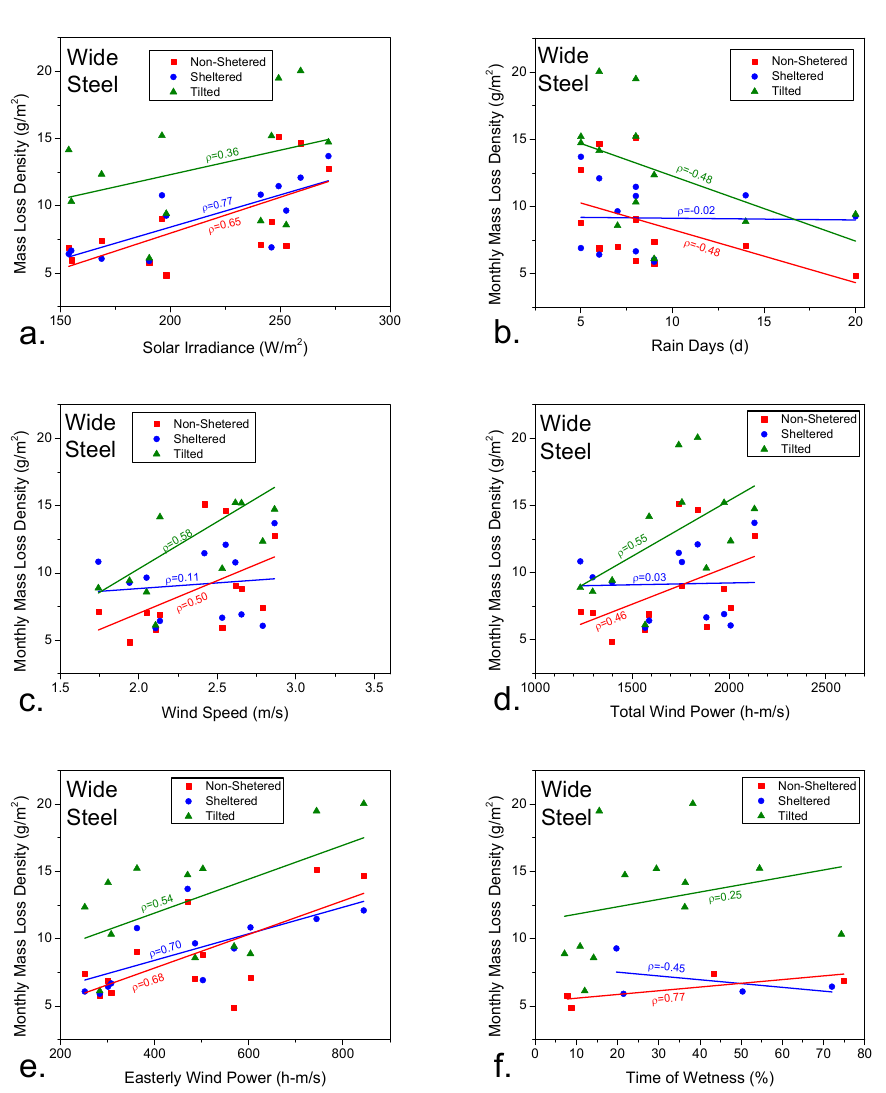
Figure 10. The effect of environmental parameters on the steel mass loss density, on a monthly basis. Correlations are observed for solar irradiance ( a ), rain days ( b ), mean wind speed ( c ), total wind power ( d ), easterly wind power ( e ), and time of wetness ( f ). Table 1. Pearson correlation coefficients of the (assumed linear) relationship between Wide steel mass loss density and various environmental parameters. Cells are color-coded as follows: ρ < − 0.5 (dark